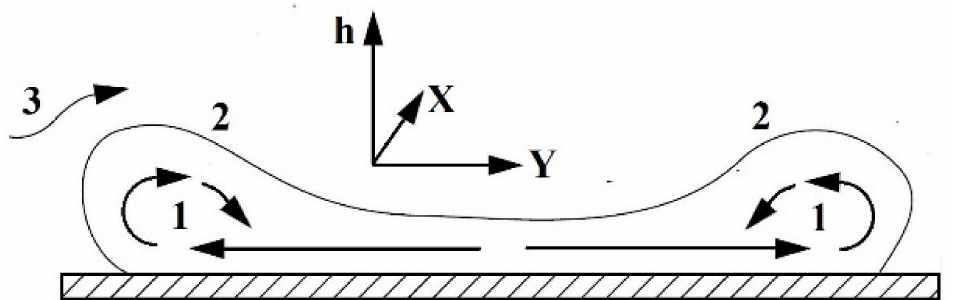
Figure 13. Model of dense gas gravity spreading. 1 Vortex forces in a gas cloud. 2 Heads of a dense cloud. 3 Crosswind blowing across the cloud. Descriptions: X—downwind direction; Y—crosswind direction; h—vertical